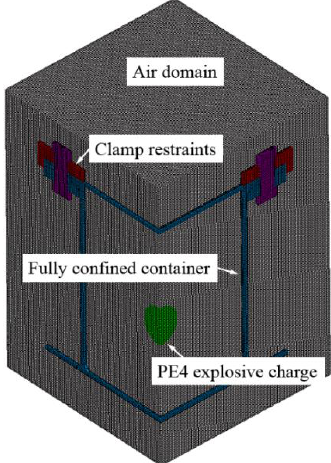
Figure 4. Quarter of the three-dimensional numerical model.